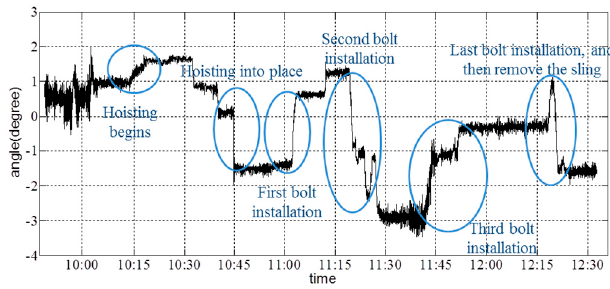
Figure 19. Angle about the y- axis of the girder during hoisting.